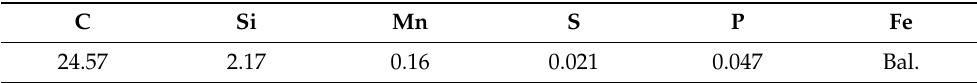
Table 1. The chemistry of nodular cast iron QT00-2 (mass fraction,